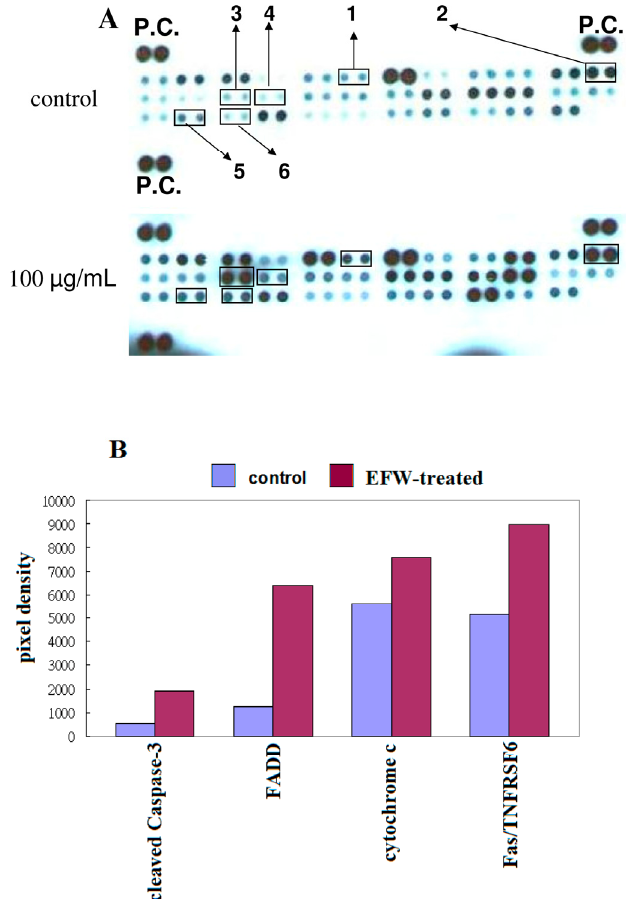
Figure 5. ( A ) The caspase-dependent apoptosis induced by treating THP-1 cells with 100 μ g/mL EFW (red) or with no treatment (control; blue) for 24 h was examined by an apoptosis array analysis of whole cell lysates. The black underlines indicate (1) cleaved caspase-3, (2) cytochrome c, (3) FADD, (4) Fas/TNFRSF6, (5) p21, (6) p27, and (P.C.) positive control; ( B ) An image analyzer quantified the expression levels of the apoptosis-related proteins from THP-1 cells treated with 100 μ g/mL EFW or with distilled water (control). Data represent mean ± S.D. of four measurements from two independent apoptosis array